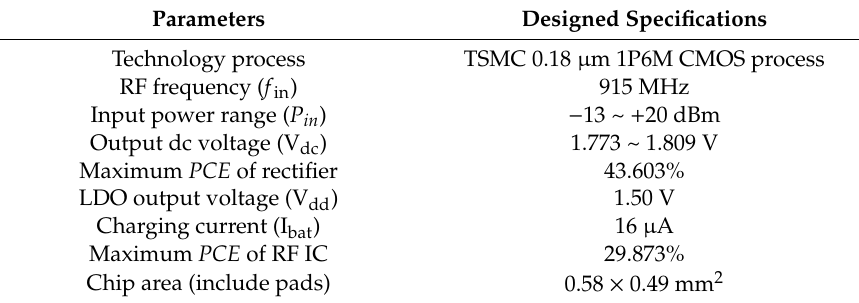
Table 2. Simulated specifications of the proposed RF-energy-harvesting IC.